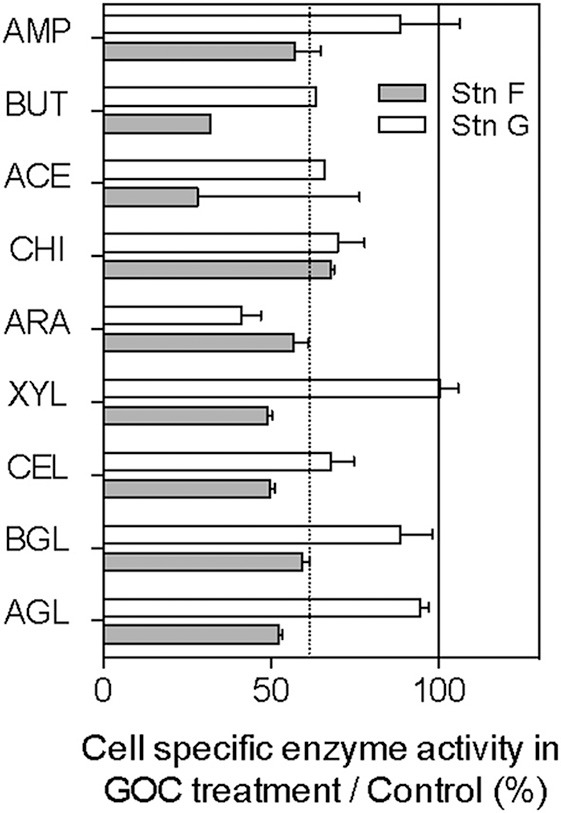
Cell-specific enzyme activity in GOC treatment as percentage of the values observed in the controls. The dotted line shows the median value and the continuous line shows the 100% line indicating no effect of GOC. Hydrolytic enzyme activities were measured only in the Arctic stations F and G. AMP, L-leucyl aminopeptidase; BUT, butyrate esterase, ACE, acetate esterase; CHI, chitobiase; ARA, α-L-arabinosidase; XYL, β-D-xylosidase; CEL, cellobiosidase; BGL, β-D-glucosidase; and AGL, α-D-glucosidase.